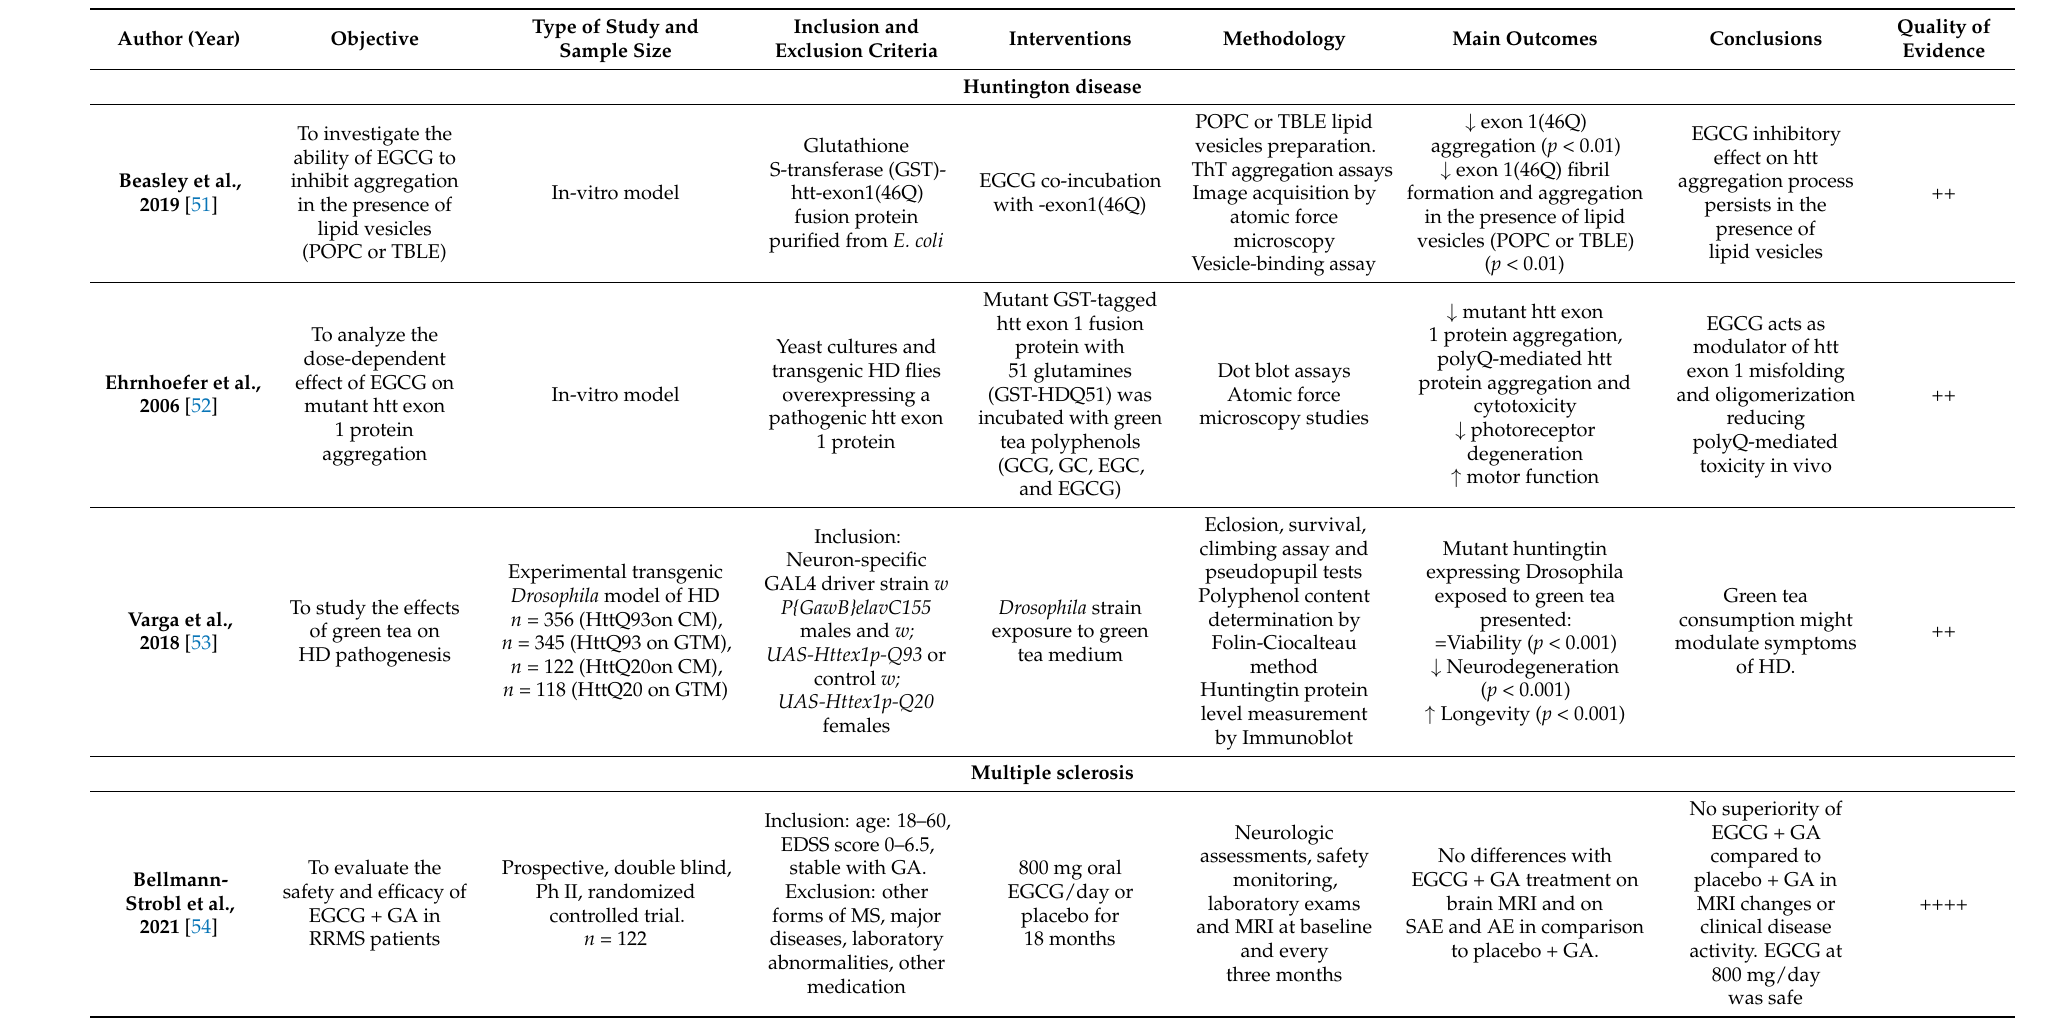
Table 1. Catechin use in neurodegenerative